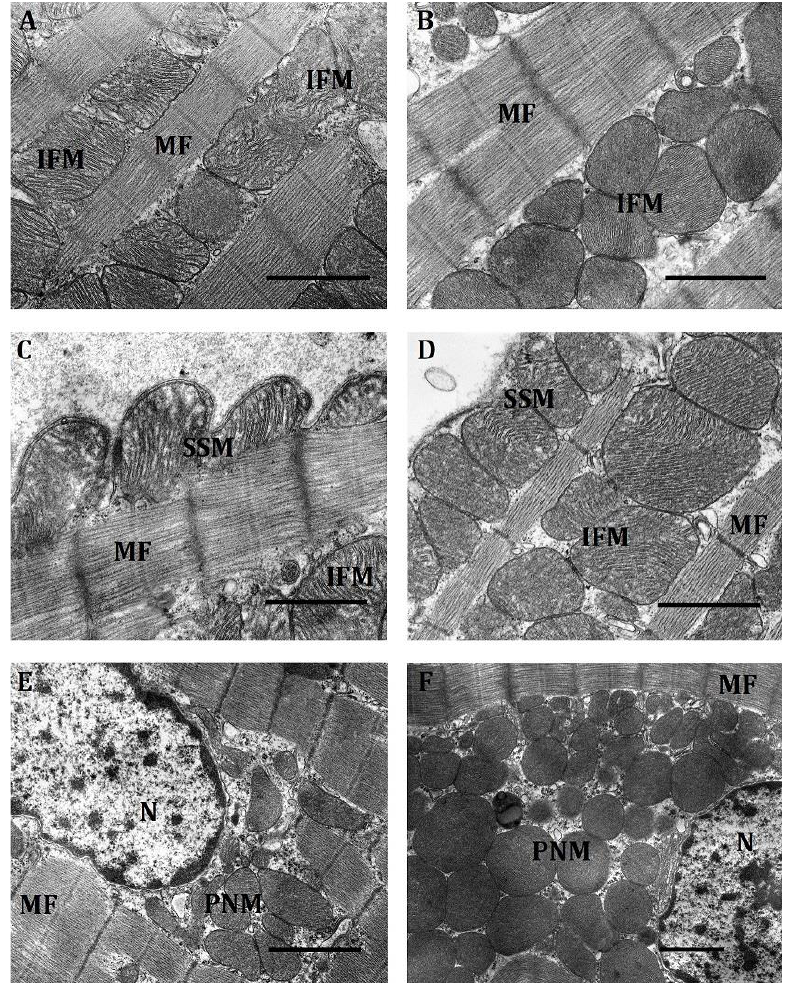
Figure 2. The ultrastructure of a part of a cardiomyocyte in rats with low ( A , C , E ) and high ( B , D , F ) resistance to oxygen deficit under normoxic conditions. Representative electron microscopy images showing intermyofibrillar ( A , B ), subsarcolemmal ( C , D ) and perinuclear ( E , F ) mitochondria; IFM, SSM and PNM are interfibrillar, subsarcolemmal and perinuclear mitochondria, respectively; MF, myofibrils; N, nucleus. Scale bar, 0.5 μm.